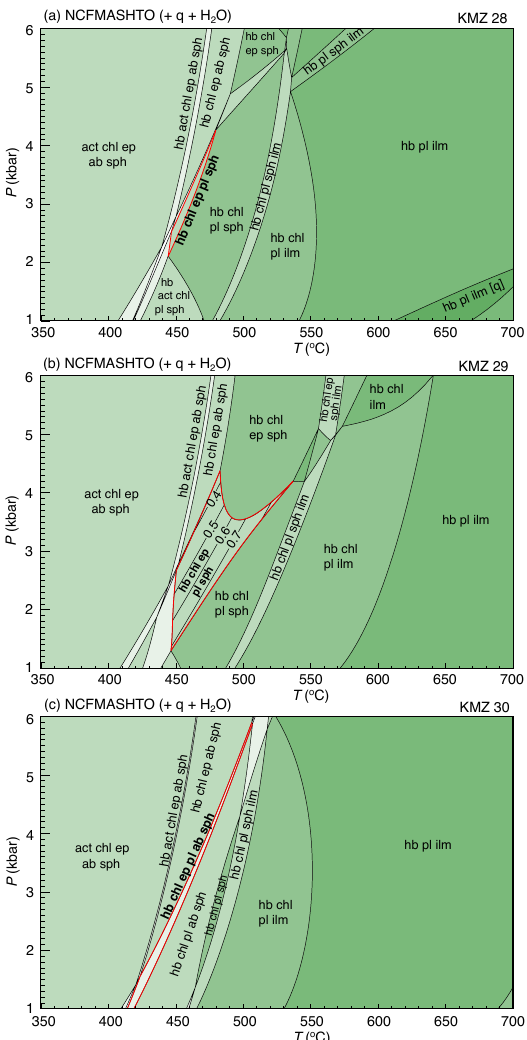
Figure 5. P – T pseudosections calculated for mafic schists from the KMZ. The inferred equilibrium mineral assemblages are outlined by red boxes and indicated in bold type. Contours in (b) are for X an in